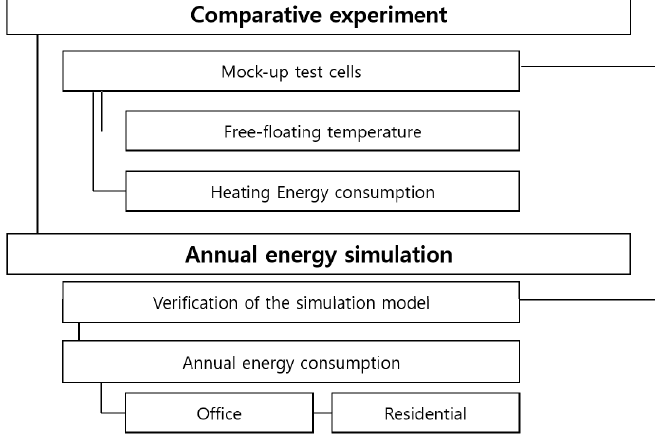
Figure 1. Technical framework of this study.